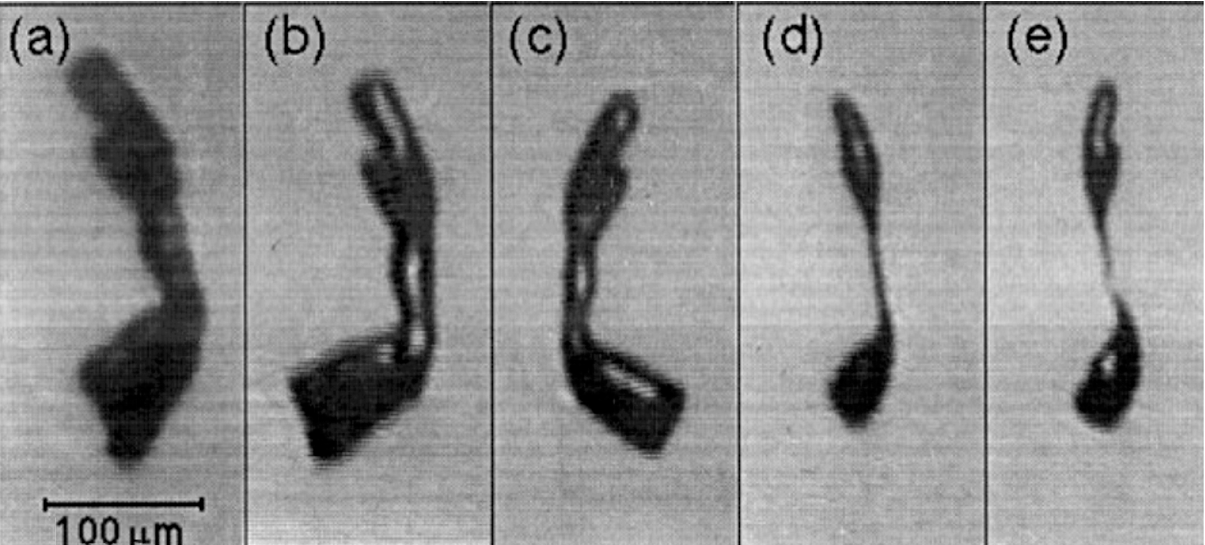
Figure 13. A sequence of images of a sublimating ice particle levitated in an EDB. Time before breakup (a) 6min, (b) 4min, (c) 2min, (d) 20s, and (e) at the moment of breakup (Bacon et al.,